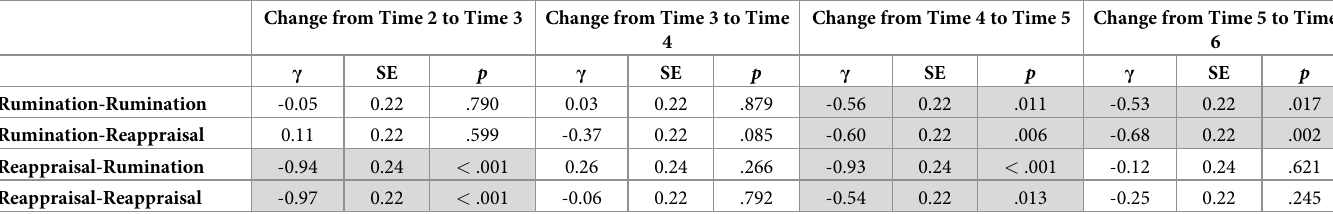
Significant effects at p > .05 are shaded in grey.